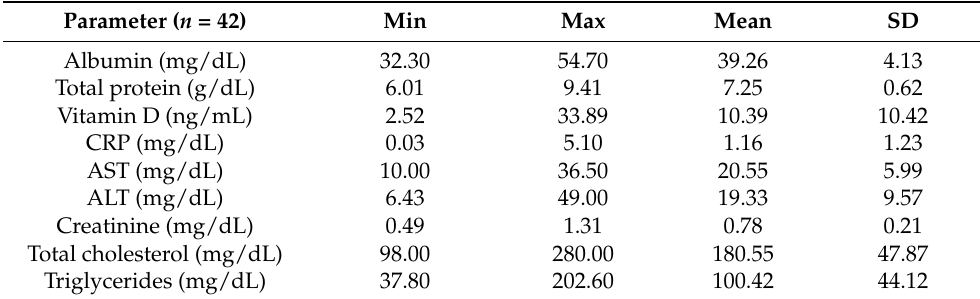
Table 2. Biochemical